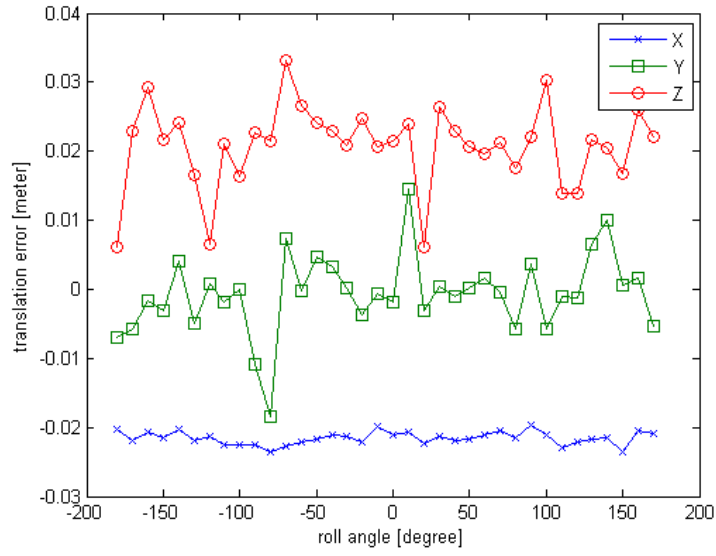
Figure 7. The translation error curve of Experiment 1 for initial pose.